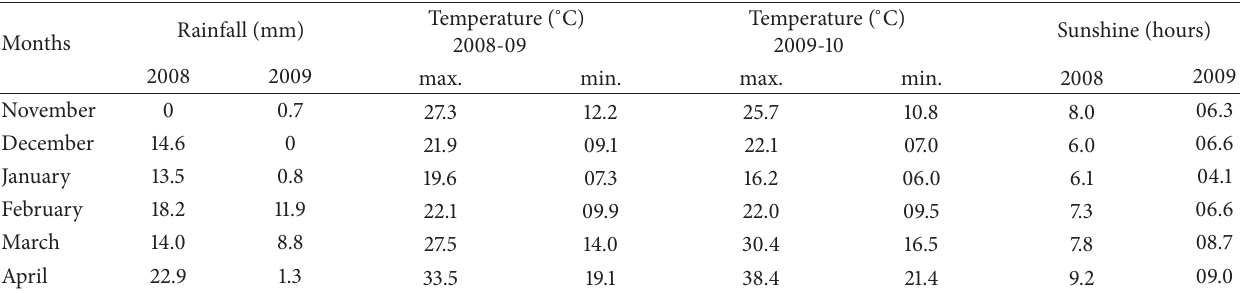
Table 2: Weather data at experimental site.